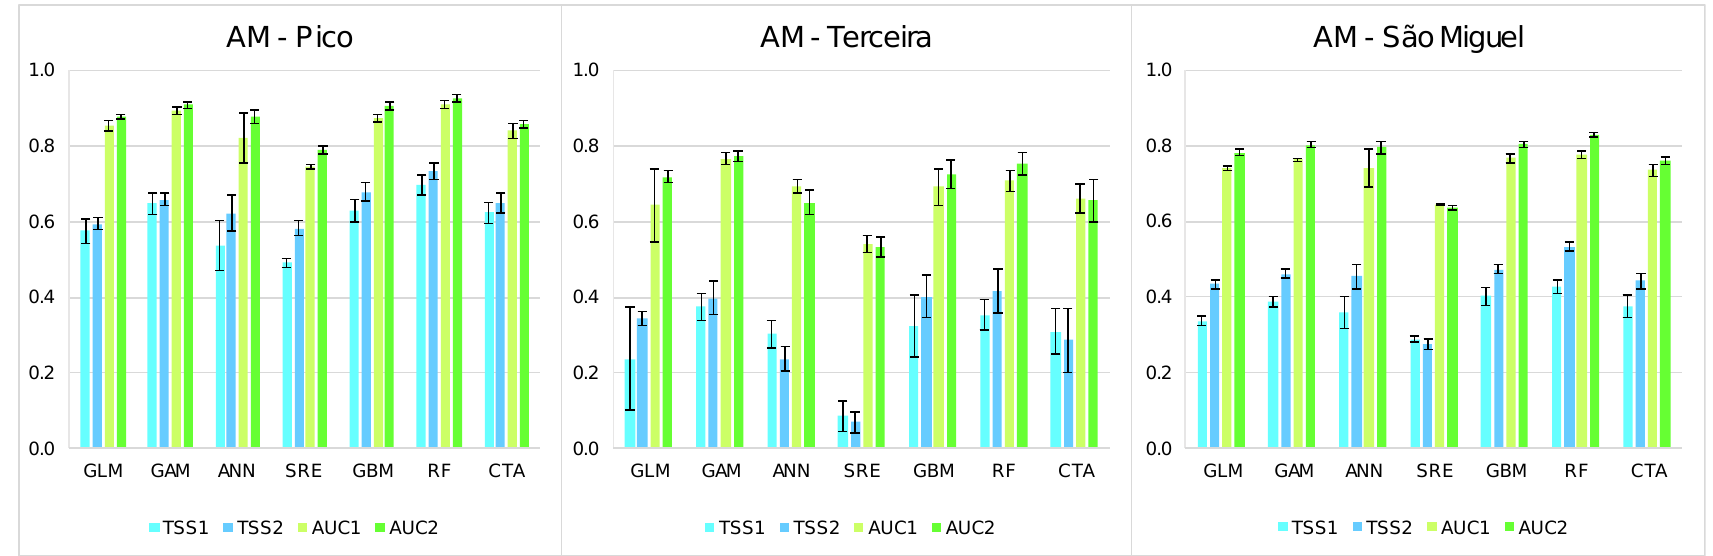
Figure 5. Evaluation of A. melanoxylon (three distinct islands) distribution models/algorithms (mean values) by the true skill statistic (TSS) and the receiver operating characteristics curve (AUC), using two different EGV sets: EGV set 1 (climatic variables) and EGV set 2 (climatic and topographic variables). The models/algorithms were: GLM (generalized linear models), GAM (generalized additive models), ANN (artificial neural networks), SRE (surface range envelope), GBM (generalized boosted regression models), RF (random forest), and CTA (classification tree analysis). TSS1: TSS of EGV set 1; TSS2: TSS of EGV set 2; AUC1: AUC of EGV set 1; AUC2: AUC of EGV set 2. Error bars correspond to the standard deviation. For more details, see Supplementary Material Tables S1 – S3.